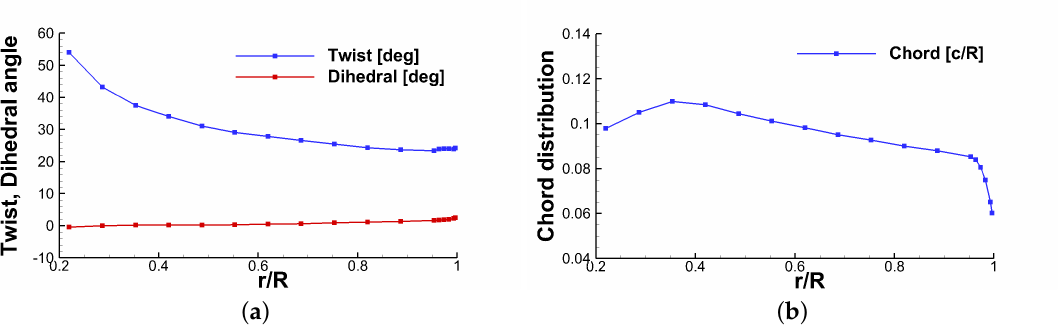
Figure 4. Geometrical description of the Varioprop 12C propeller blade. a Twist and dihedral angle distributions along the spanwise radial coordinate; b chord distribution along the spanwise radial